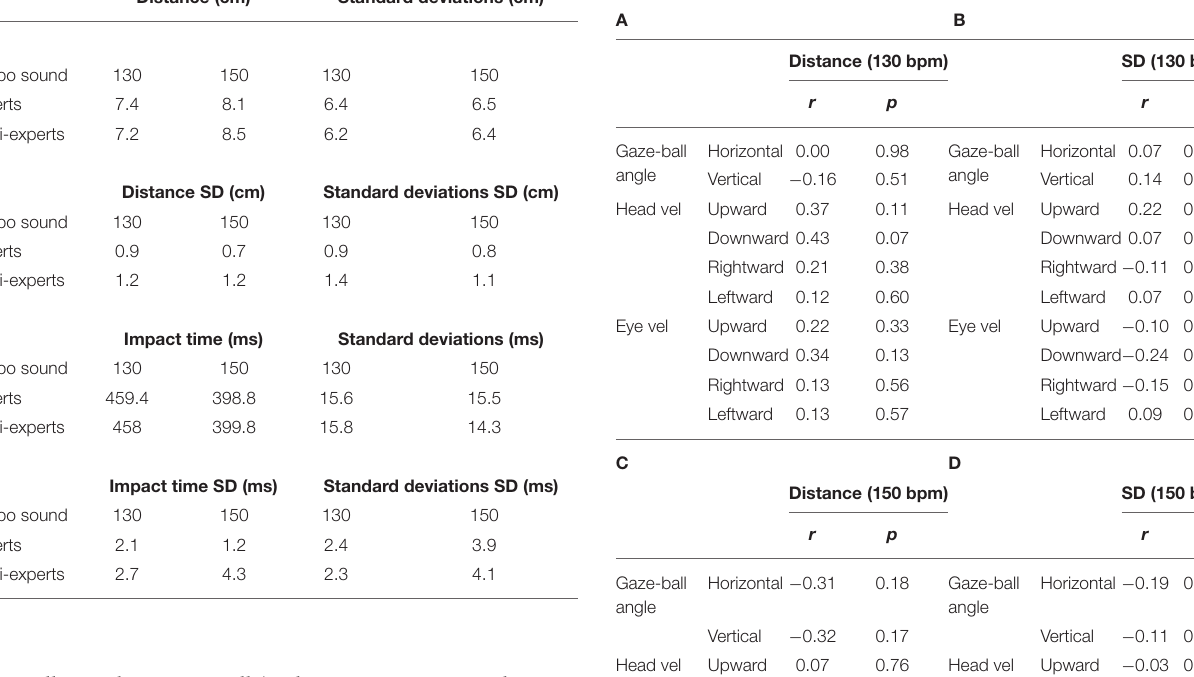
TABLE 1 | Results of distance (A,B) and impact time (C,D) in each group. Distance (cm) Standard deviations (cm)